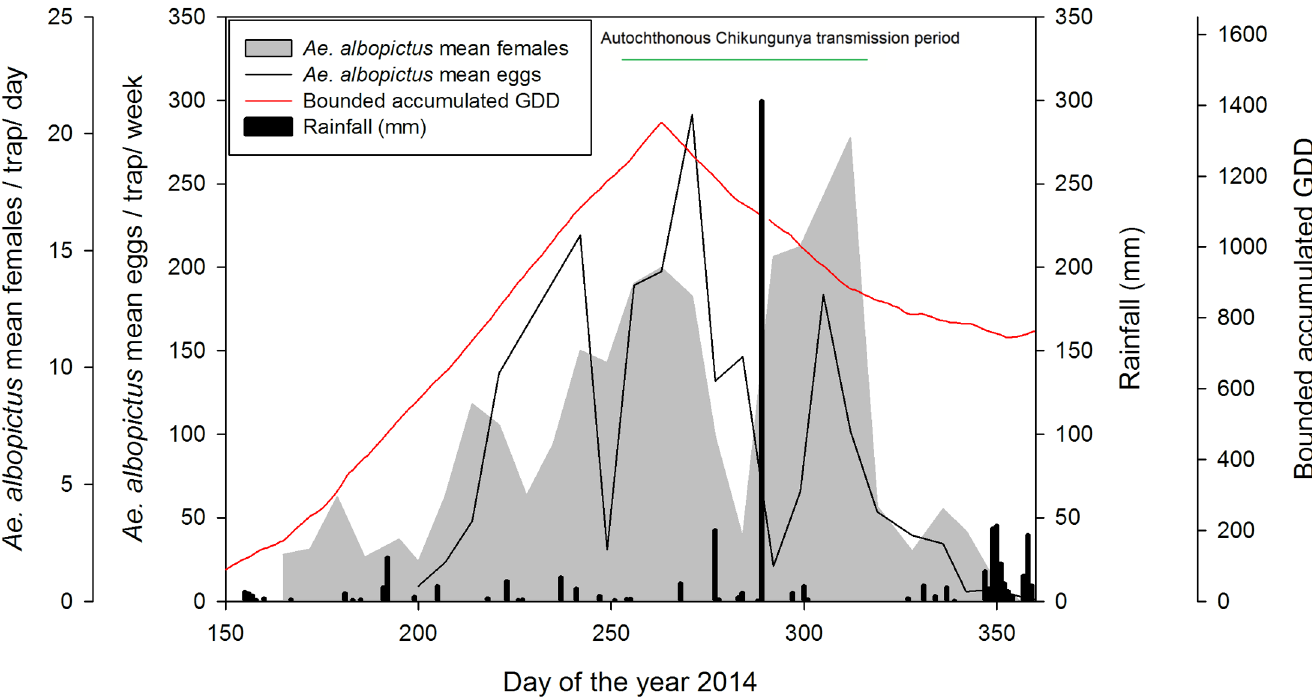
Fig 1. Mean number of Ae . albopictus eggs per trap per week (black line), Ae . albopictus females per trap per day (grey area) in 24 BGs and 24 ovitraps positioned in 8 locations in Montpellier in 2014. Autochthonous chikungunya transmission period (green line); weekly bounded accumulated Growing Degree Days (red line); weekly rainfall (black